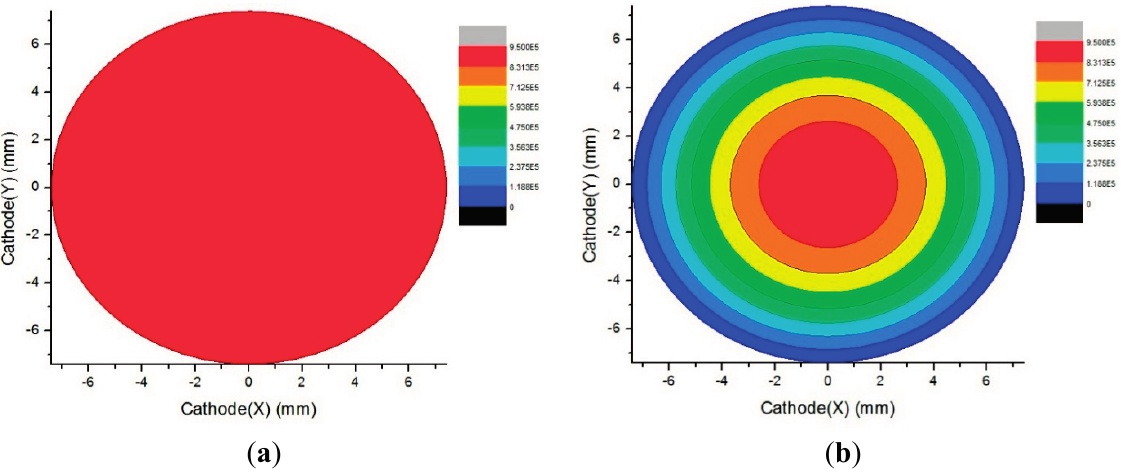
Figure 5. Calculated electric field strength on the surface of CNC FE disk ( a ) without and ( b ) with focusing cup design.